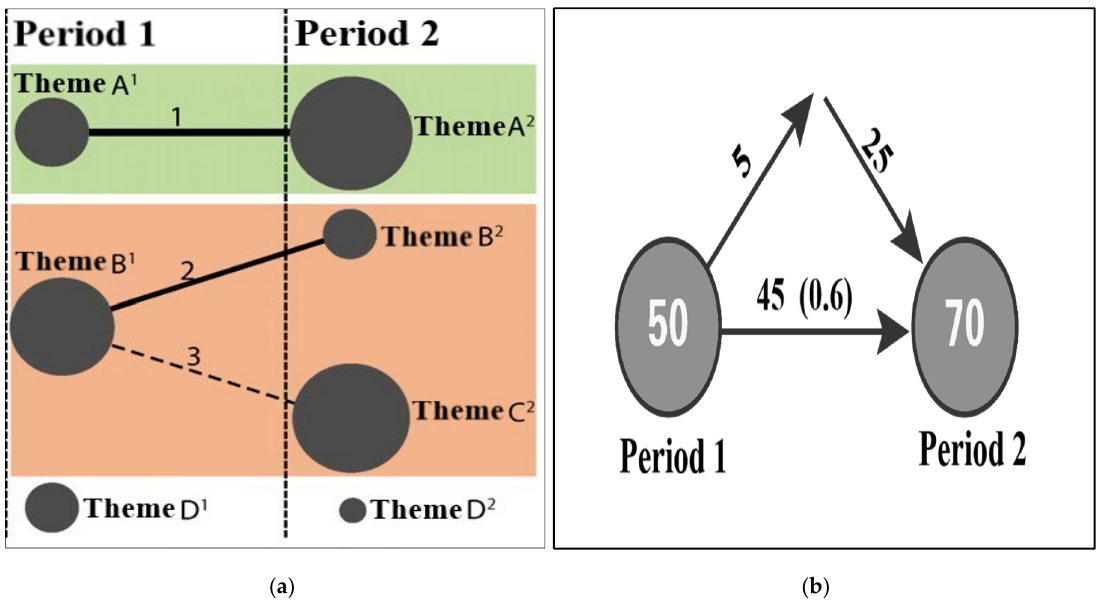
Figure 3. Examples of evolution. ( a ) Thematic evolution; ( b ) stability between periods.